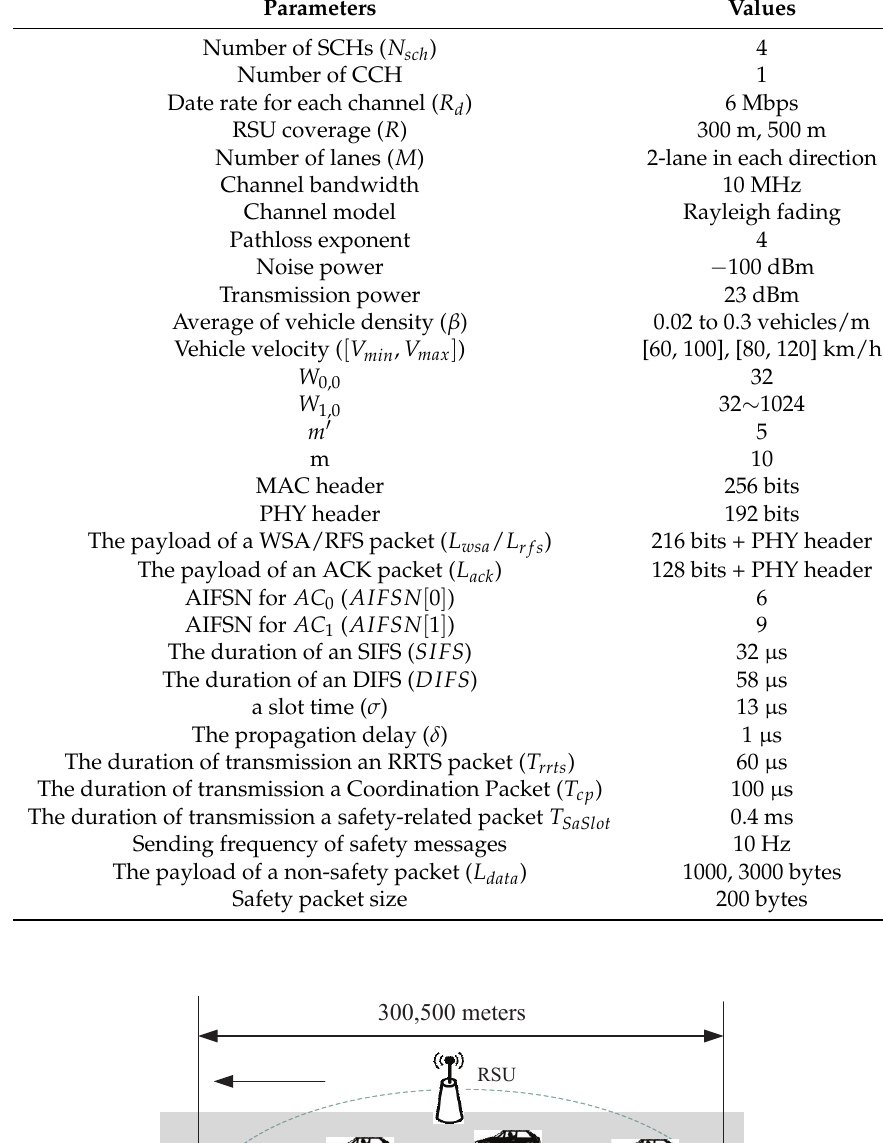
Table 3. SYSTEM PARAMETER FOR SIMULATIONS